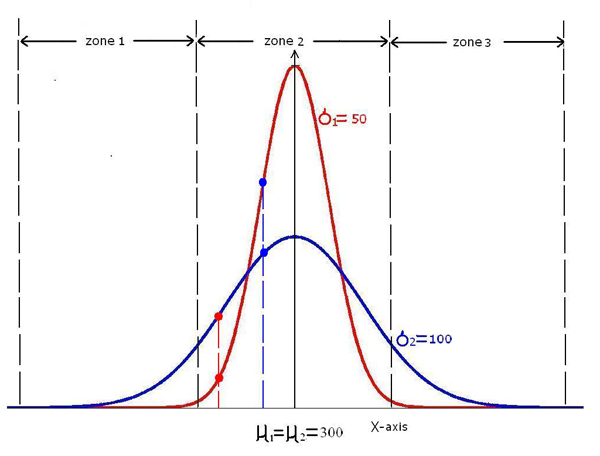
One dimension Gaussian distributions, μ1 = 600, μ2 = 700, σ1 = 50, σ2 = 100.